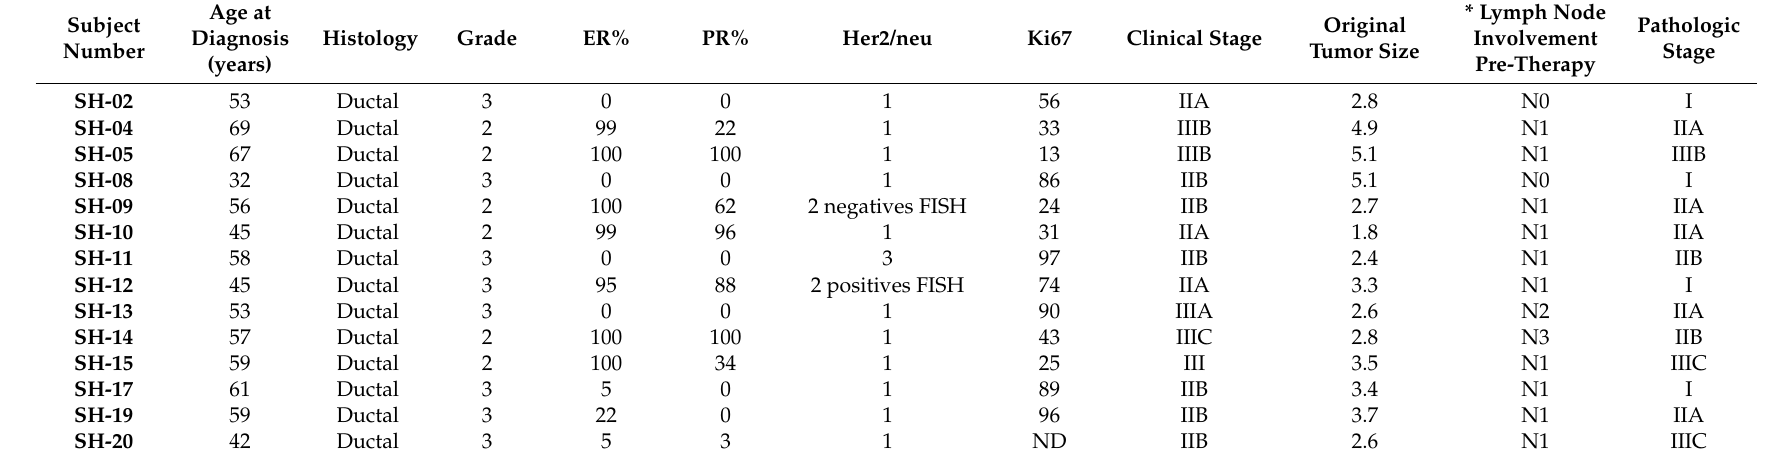
Table 1. Specific diagnoses, clinical measurements, treatment regimens, and observations for the breast cancer patients’ tumors, with incomplete pathological responses, examined in this